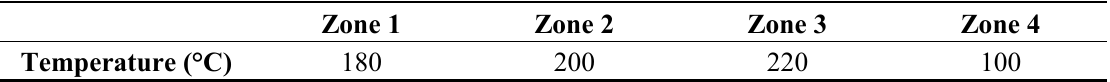
Table 3. Temperature control of PP based OFBG strain sensor fabricating